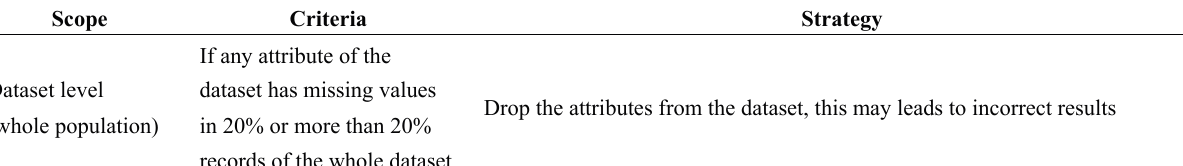
Table 3. Missing value treatment, criteria and strategies, applied to the diabetes mellitus dataset.